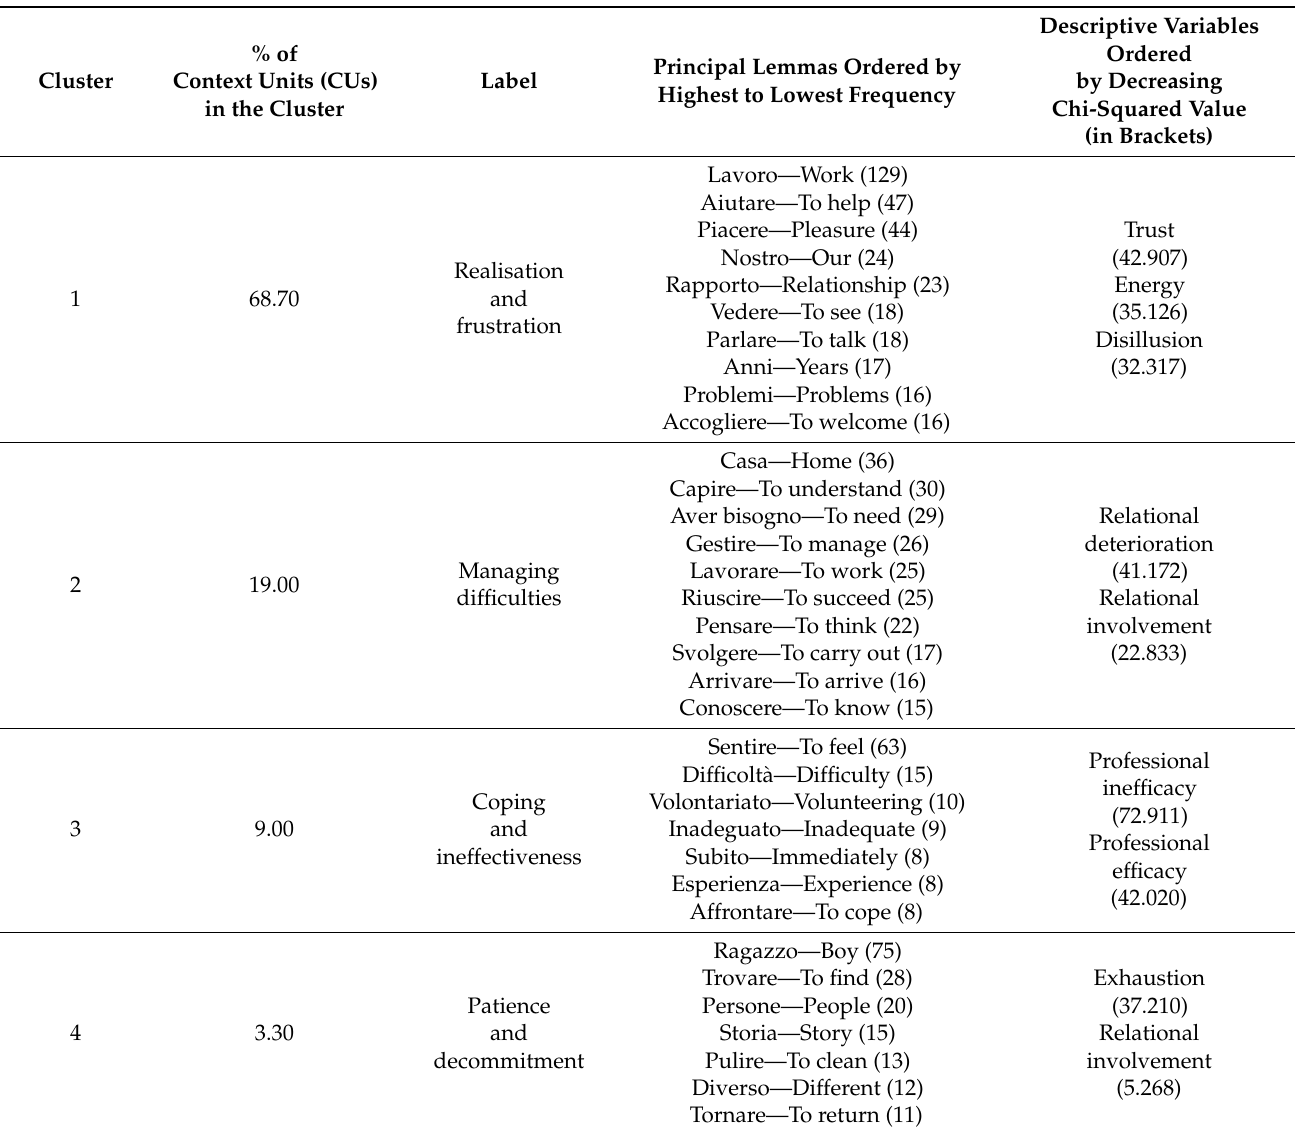
Table 2. Results of cluster analysis on first-level